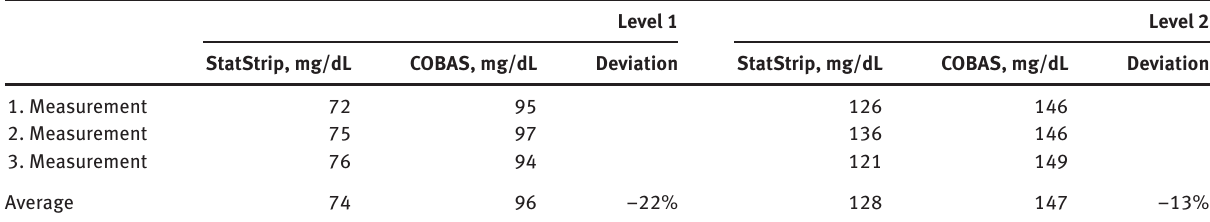
Table 2: Results of POCT devices (StatStrip) in comparison to clinical chemistry analyzer (COBAS 8000/c701).